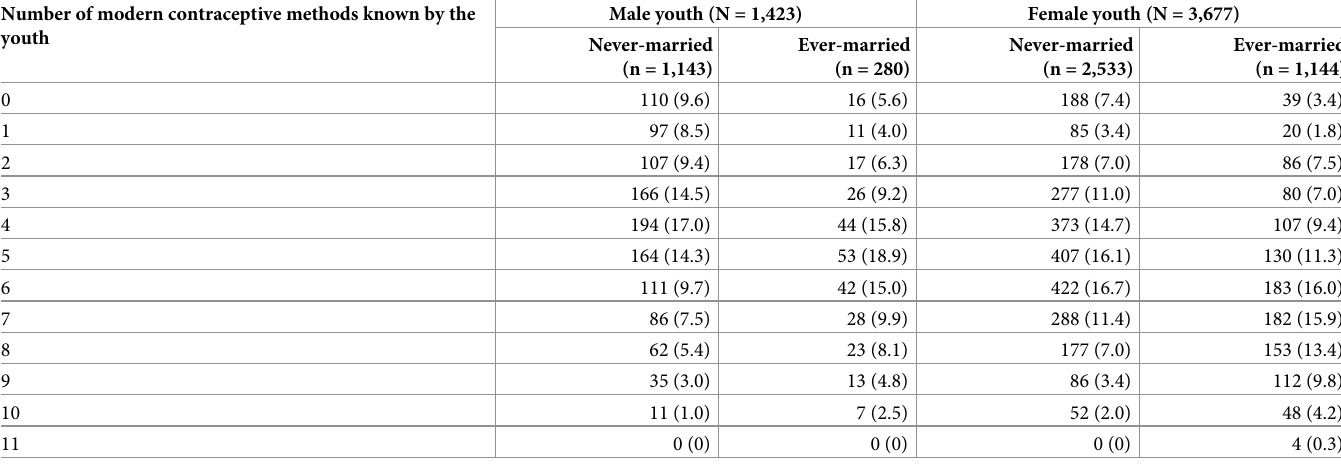
Table 2. Number of modern contraceptive methods known by youth in Myanmar. Number of modern contraceptive methods known by the youth